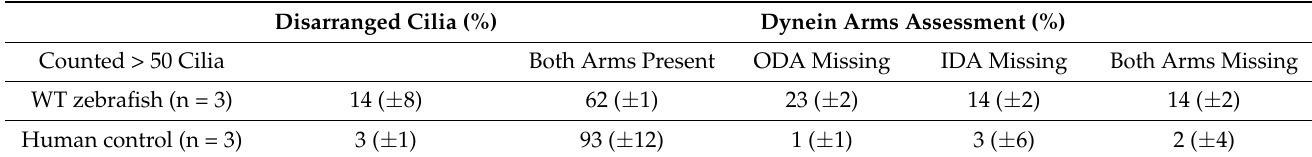
Table 2. Full TEM assessment and quantification of defects in cilia from the OP in wildtype zebrafish and human healthy controls. N=3 zebrafish OPs and n=113 cilia were examined, values shown are mean ± standard deviation.